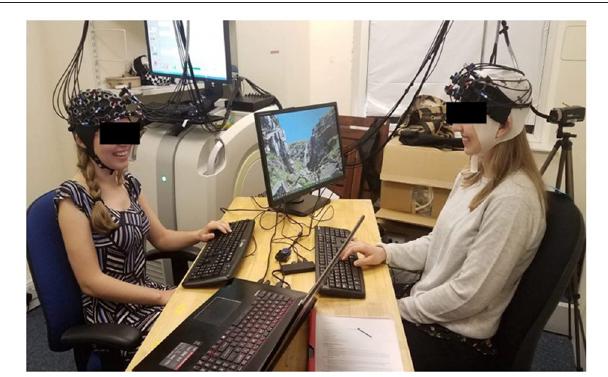
FIGURE 2 | Example paradigm of a semi-clinical environment. Pairs of individuals are seated across a table with a full field of vision of each other in a normal room. A computer screen is positioned to the side of each participant’s face to not obstruct natural facial information during verbal communication. Clinical interactions are then fractionated during fNIRS acquisition: A “client” utters a dysfunctional proposition while the “clinician” listens to this, then critically thinks about what makes the belief irrational, and finally verbally disputes the appraisal while the client carefully listens. These epochs would constitute one trial in a block; other blocks mnight involve reversing roles or changing the nature of the intervention